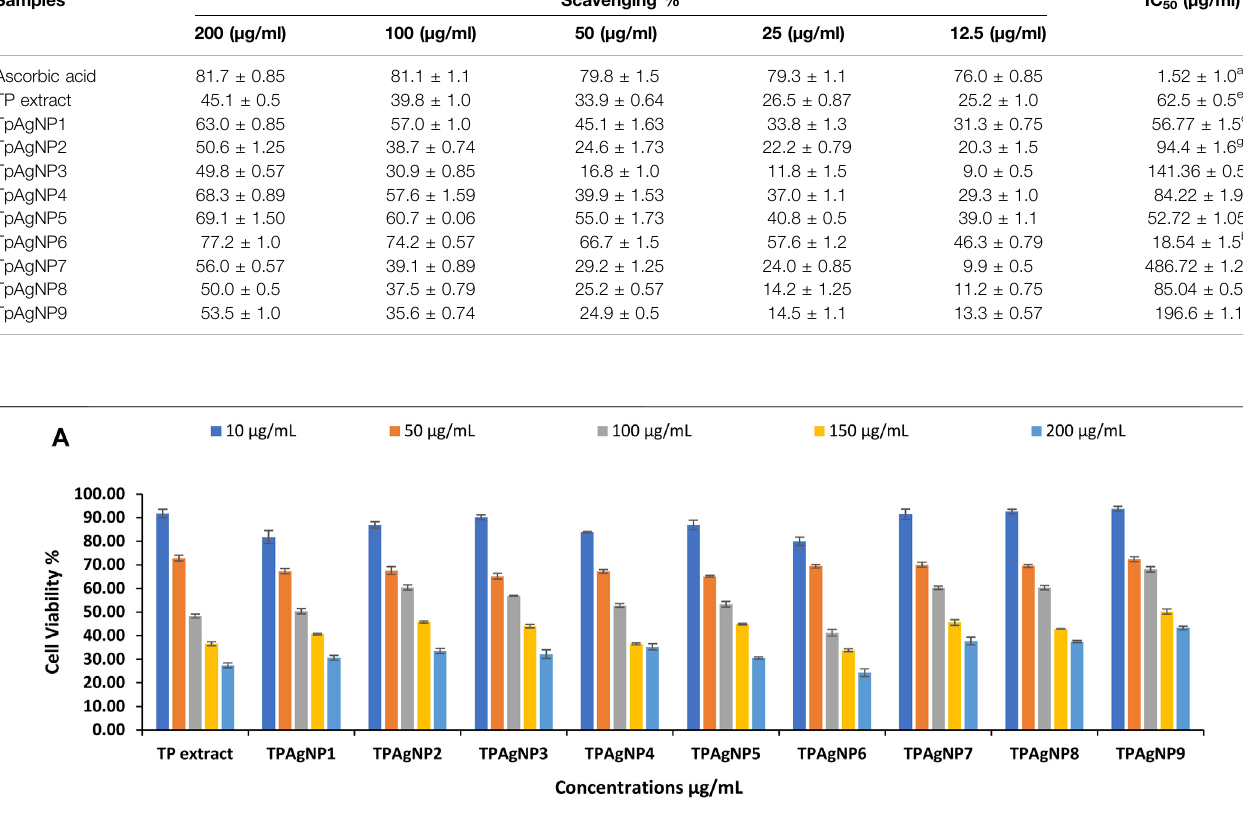
TABLE 2 | Antioxidant activity of plant extract and biosynthesized TpAgNPs of T. pallida . Samples